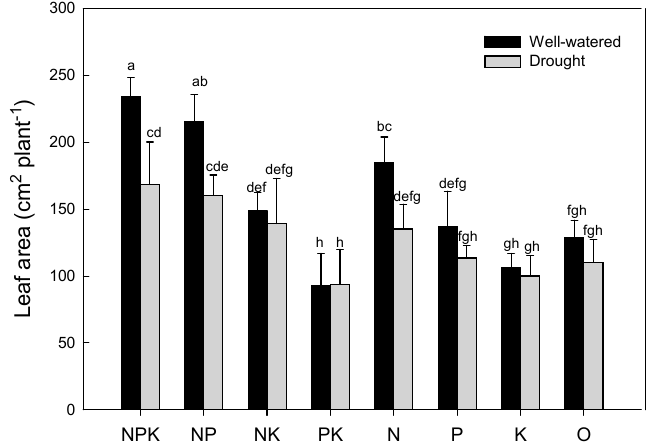
Figure 1. Interactive effects of drought and the N, P and K nutrients applied individually or in combination, or with no nutrient application (0) on the leaf area of the maize seedlings at day 20 after sowing. The error bars represent the standard errors of the mean ( n = 3) and fit within the plot symbol if not visible. Means accompanied by different letters are significantly different at p < 0.05.